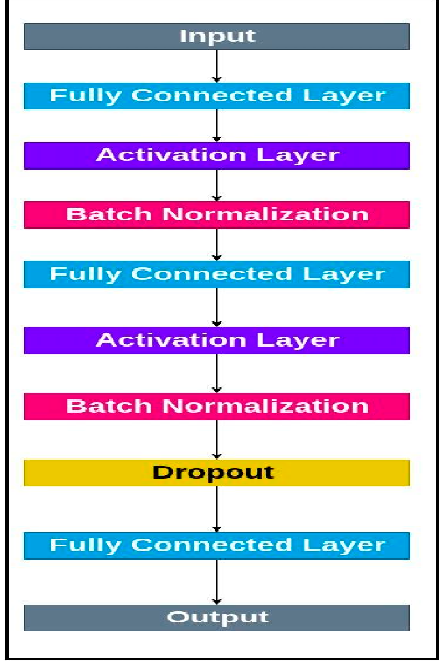
Figure 9. The architecture of the proposed DNN-based classifier.